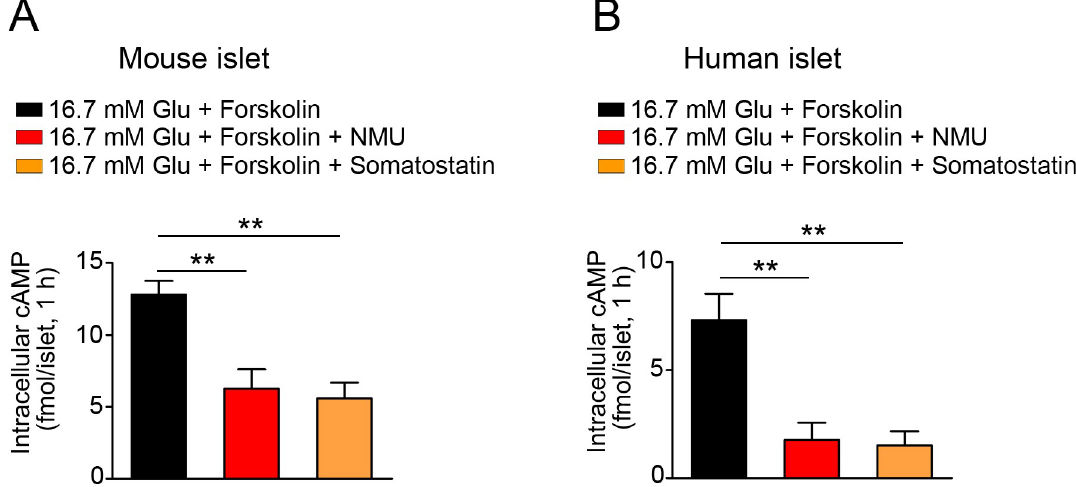
Fig 2. Effects of NMU on intracellular cAMP production. Intracellular cAMP levels in mouse islets (A) ( n = 4) and human islets (B) ( n = 4) with or without NMU or somatostatin treatment under 16.7 mM glucose. �� P < 0.01.